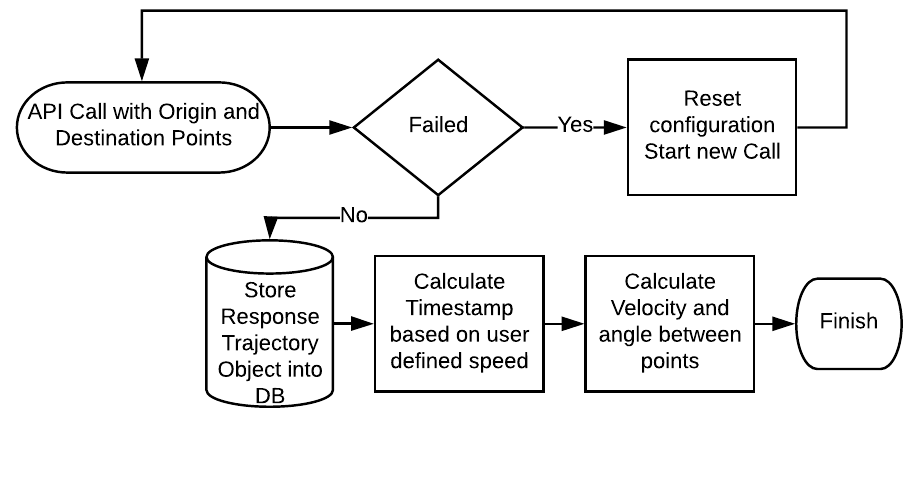
Figure 1. Data flow